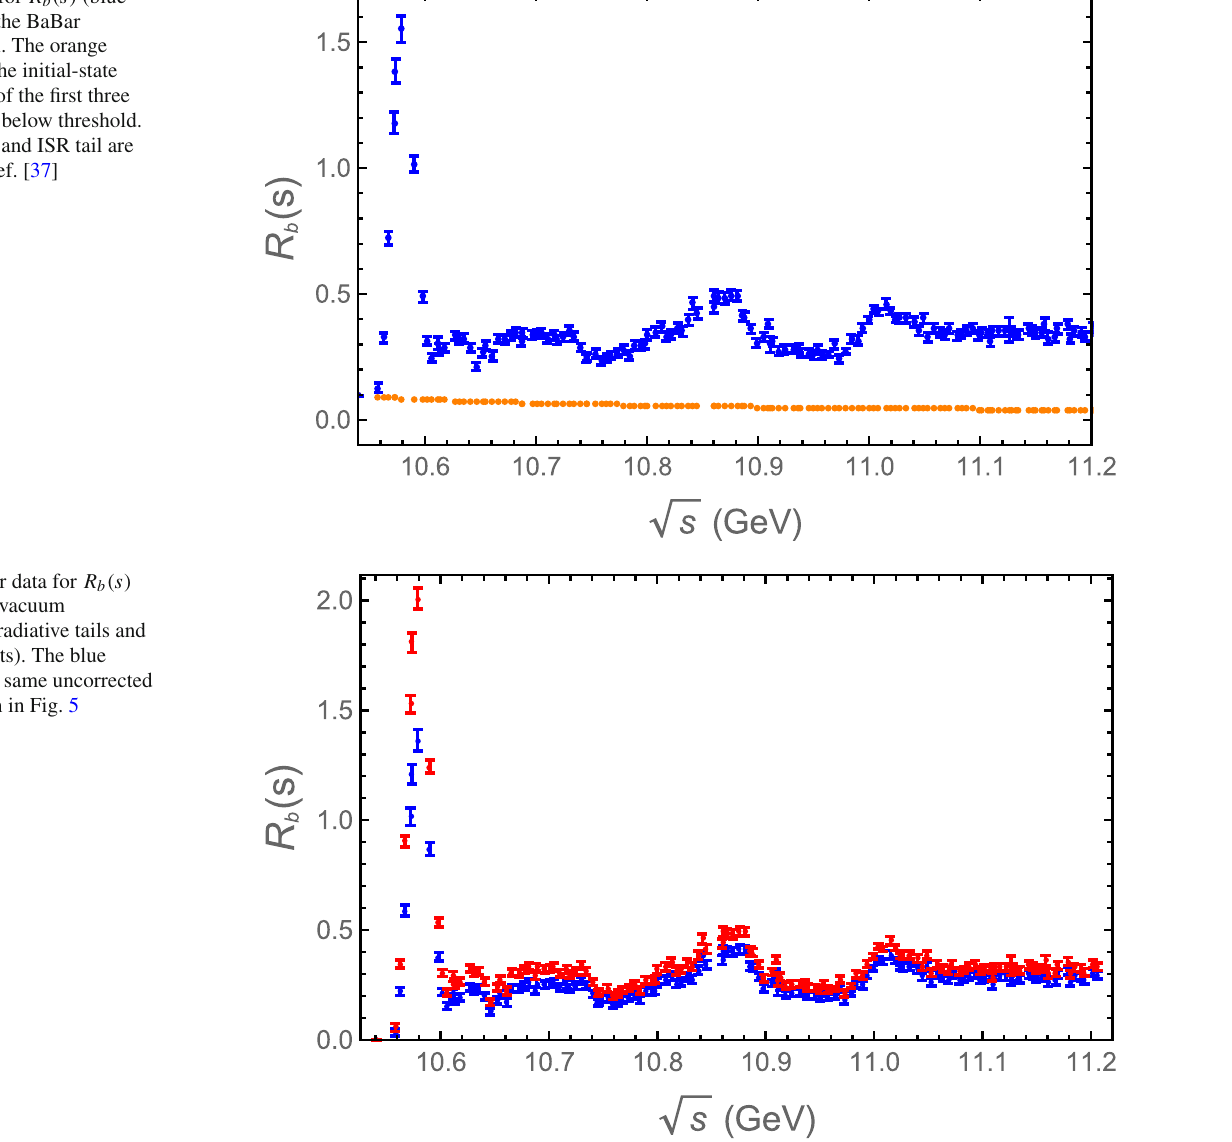
Fig. 6 BaBar data for R b ( s ) corrected for vacuum polarization, radiative tails and ISR (red points). The blue points are the same uncorrected data as shown in Fig.